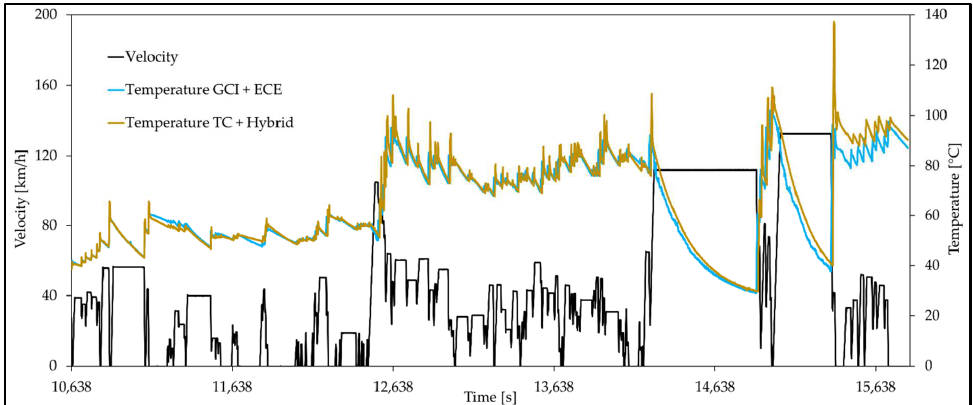
Figure 14. Temperature evolution of the HMC pairing compared to the CGI pairing during WLTP Brake Cycle Trip 10.